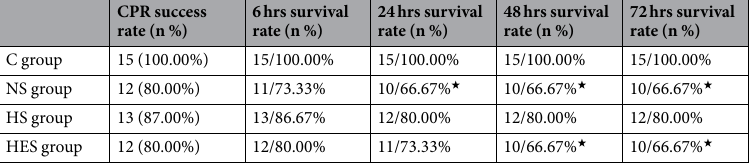
Table 1. Success rate for CPR and survival rates post-surgery in the study rats. Note: ★ P < 0.05 versus control group at the same